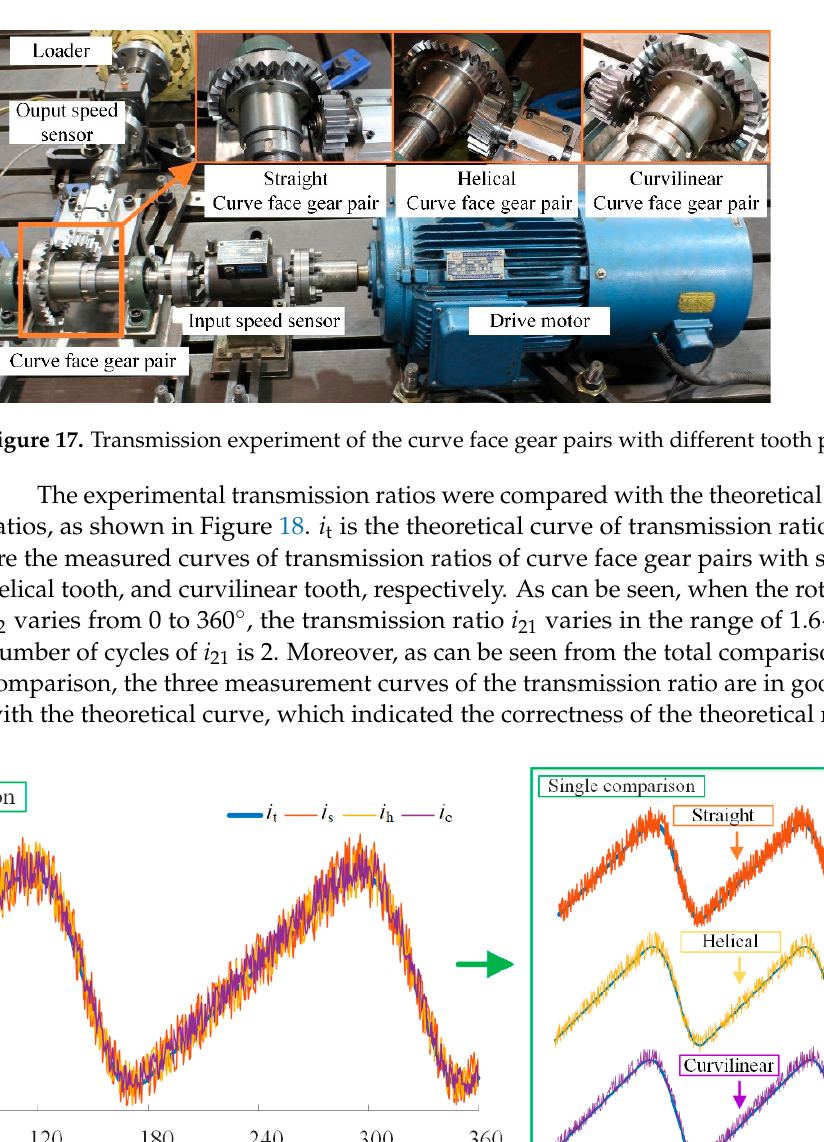
Figure 19. Maximum relative error of the transmission ratio experiment.